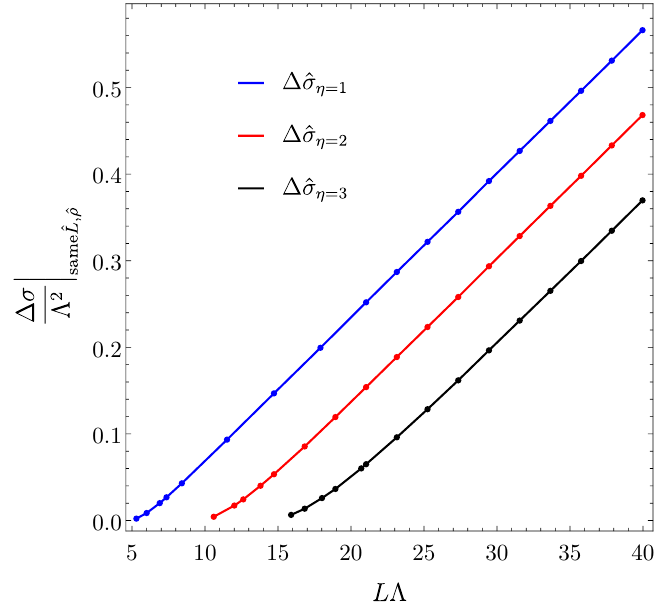
(cid:12) (between lumpy and uniform branes with (cid:12) sameˆ L, ˆ ρ ˆ E = 0 . 85 for: (1) the fundamental